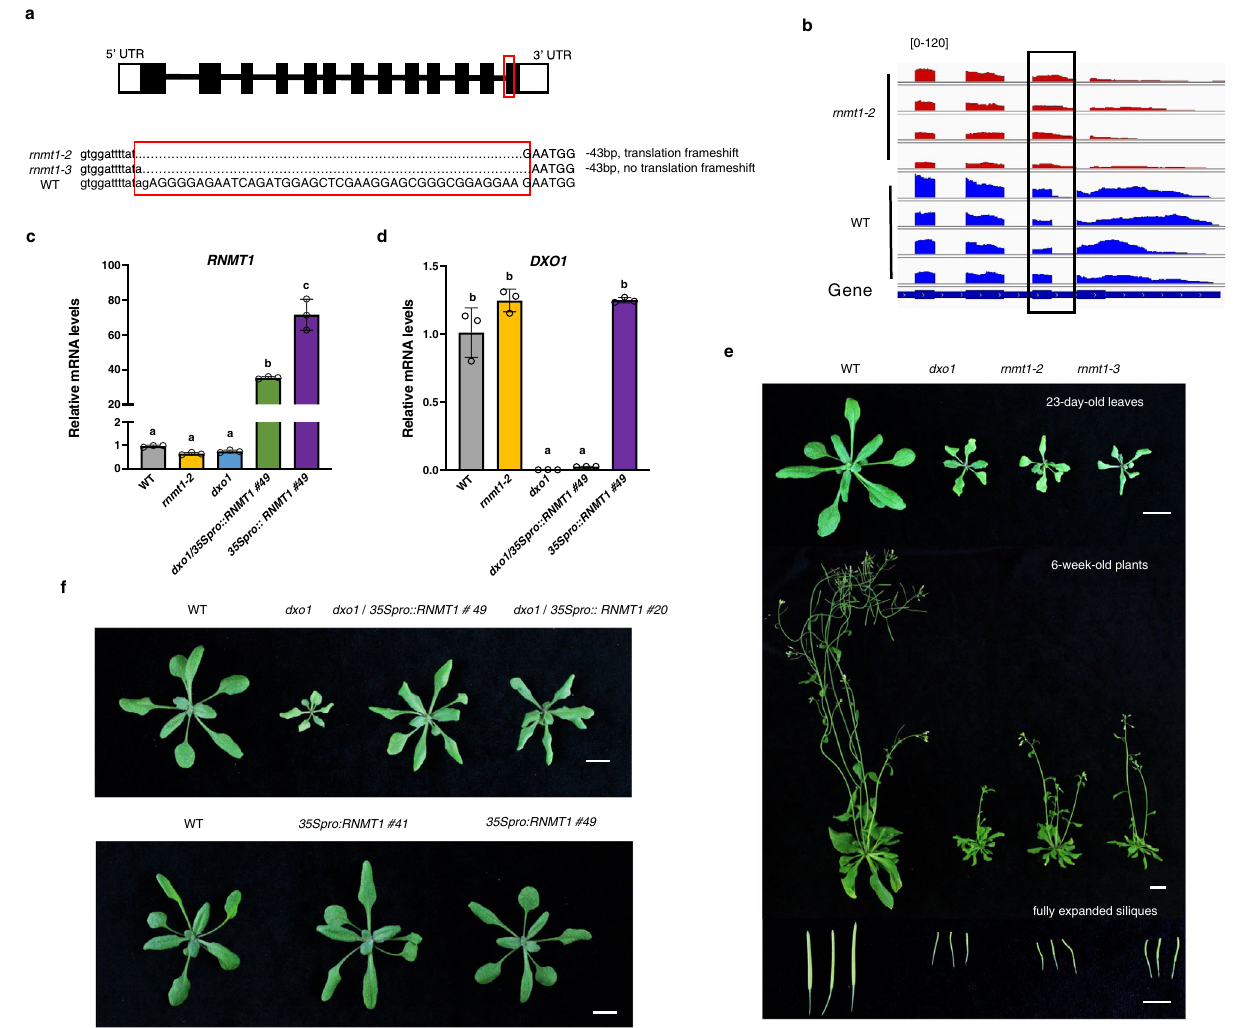
Fig. 4 | The rnmt1-2 and rnmt1-3 mutationsleadtophenotypes similarto those of dxo1 .a Schematicdiagramofthe rnmt1-2 and rnmt1-3 alleles,bothofwhichhave a43bpdeletionfromoneandtwobases,respectively,beforethelastexon.Thered frames indicate the deleted regions. The capital letters represent exon sequences and the lowercase represents intron sequences of RNMT1 . b Integrative genomic viewer (IGV)diagram of RNMT1 gene splicing pattern in rnmt1-2 and WT. The scale ofeachtrackisidentical.The Y -axisrangesfrom0to200.Therearefourrepeatsin each lines. Gene structure are shown at the bottom: exons (thick boxes), introns(lines)and3 ′ UTR(lines).Theblackframeincludesthelastintronwhichwas